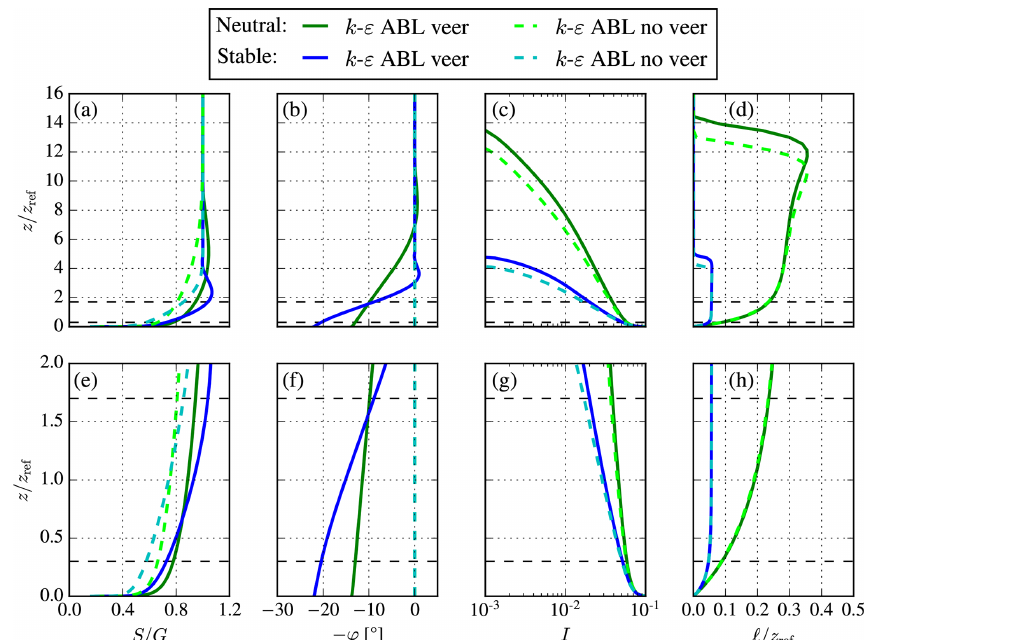
Figure 4. Comparison of k – ε ABL models (with and without wind veer) for stable ( (cid:96) max = 5m) and neutral ( (cid:96) max = 30m) conditions offshore using G = 10ms − 1 , f c = 2 f pg = 10 − 4 s − 1 and z 0 = 10 − 4 m. Bottom plots (e–h) are a magnified view of the top plots (a–d) , focused around a 5MW wind turbine rotor area, which is depicted as black dashed lines. (a, e) Wind speed. (b, f) Wind direction. (c, g) Turbulence intensity. (d, h) Turbulence length